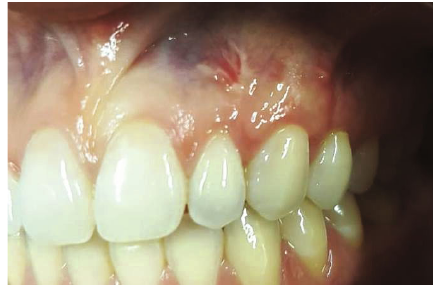
Figure 13: 60-day postoperative follow-up.